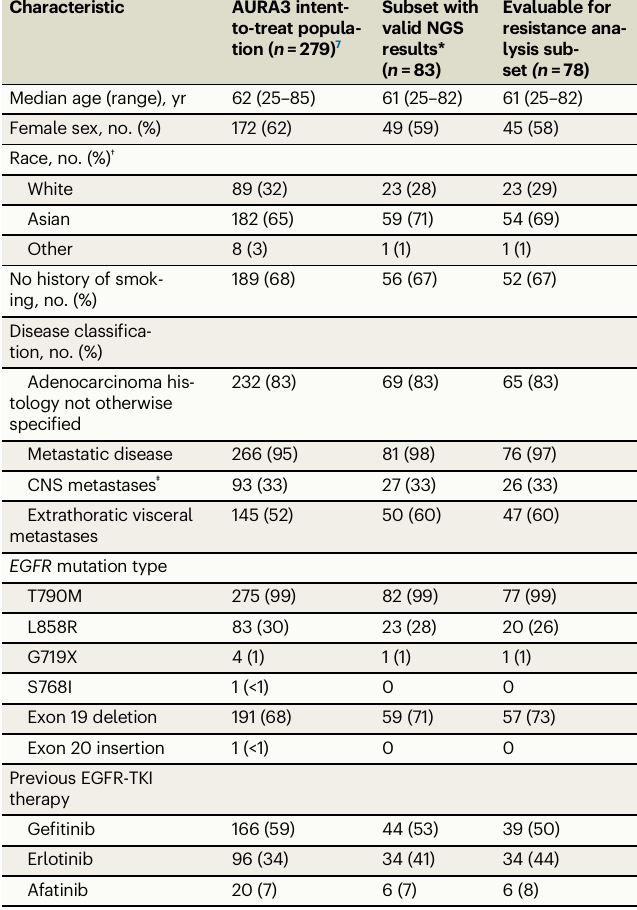
Table 1 | Baseline characteristic of osimertinib-treated patients evaluable for analysis of acquired resistance